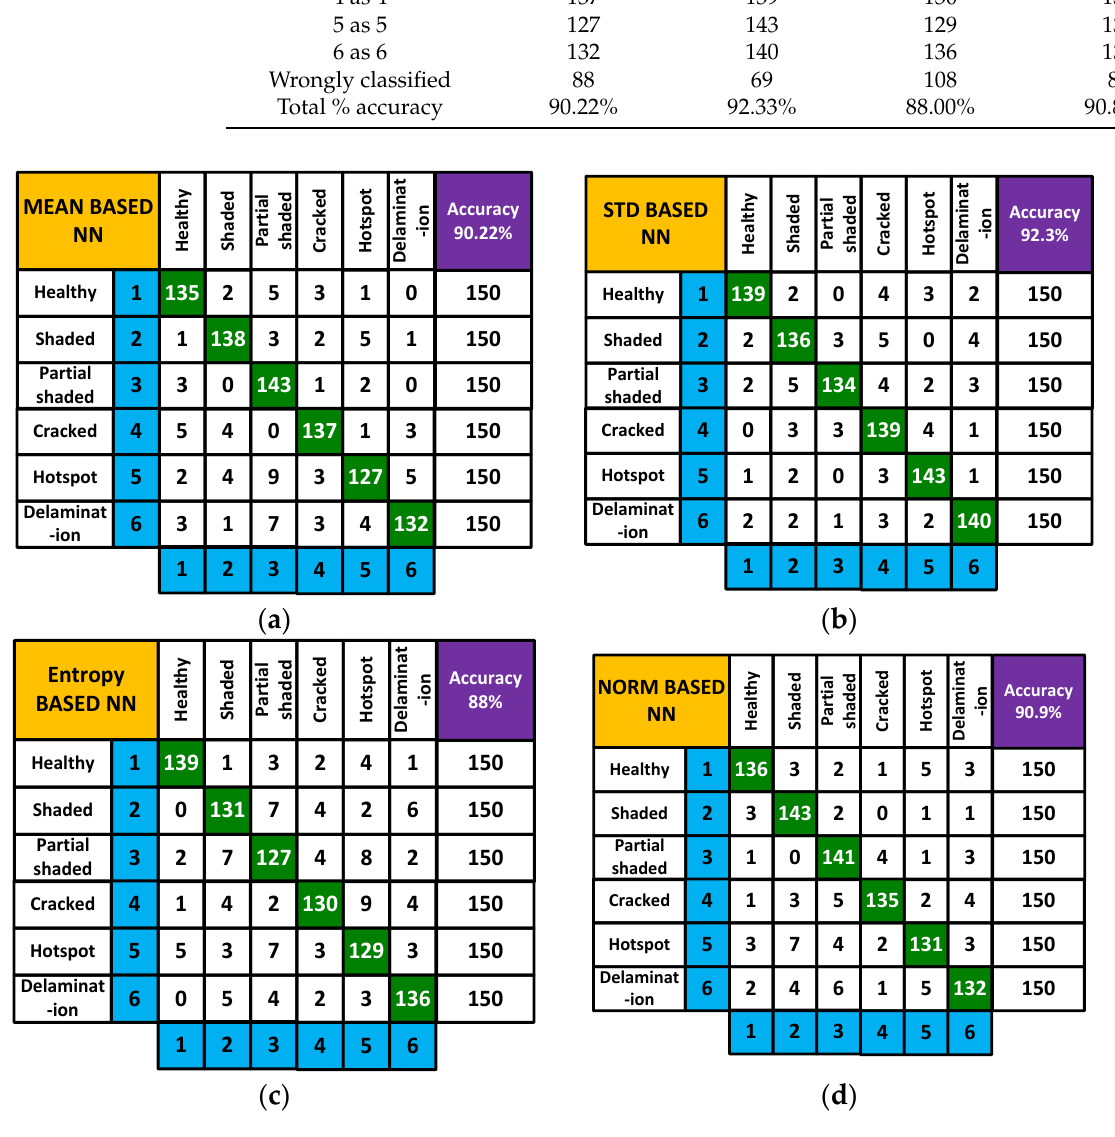
Figure 17. Confusion matrix diagram of ( a ) mean-based NN classifier, ( b ) standard deviation-based NN classifier, ( c ) entropy-based NN classifier, and ( d ) norm-based NN classifier.